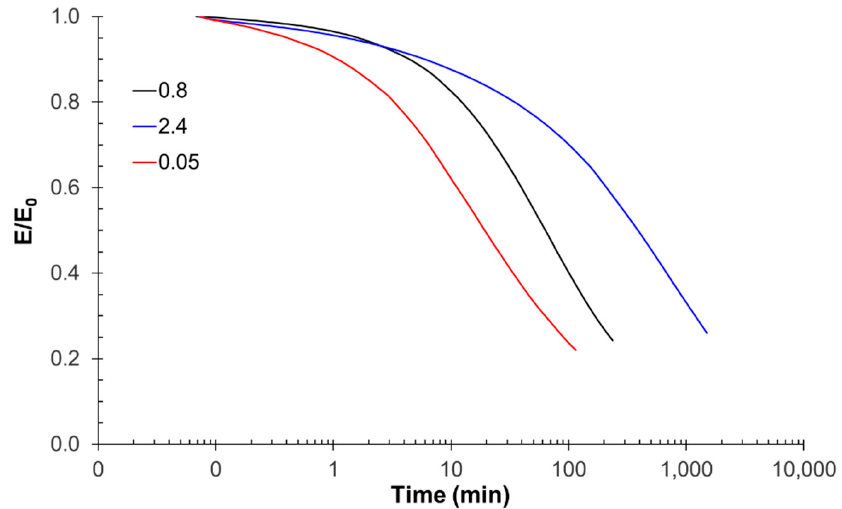
Figure 5. Stress relaxation as influenced by the amount of coupling agent (GMA).